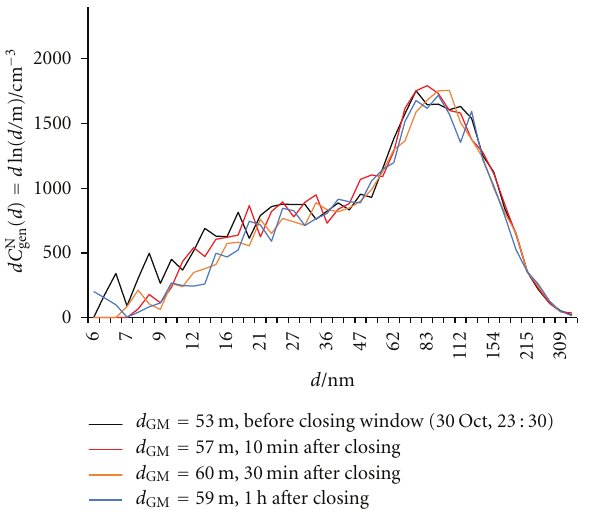
Figure 14: Number size distributions (d C N in the